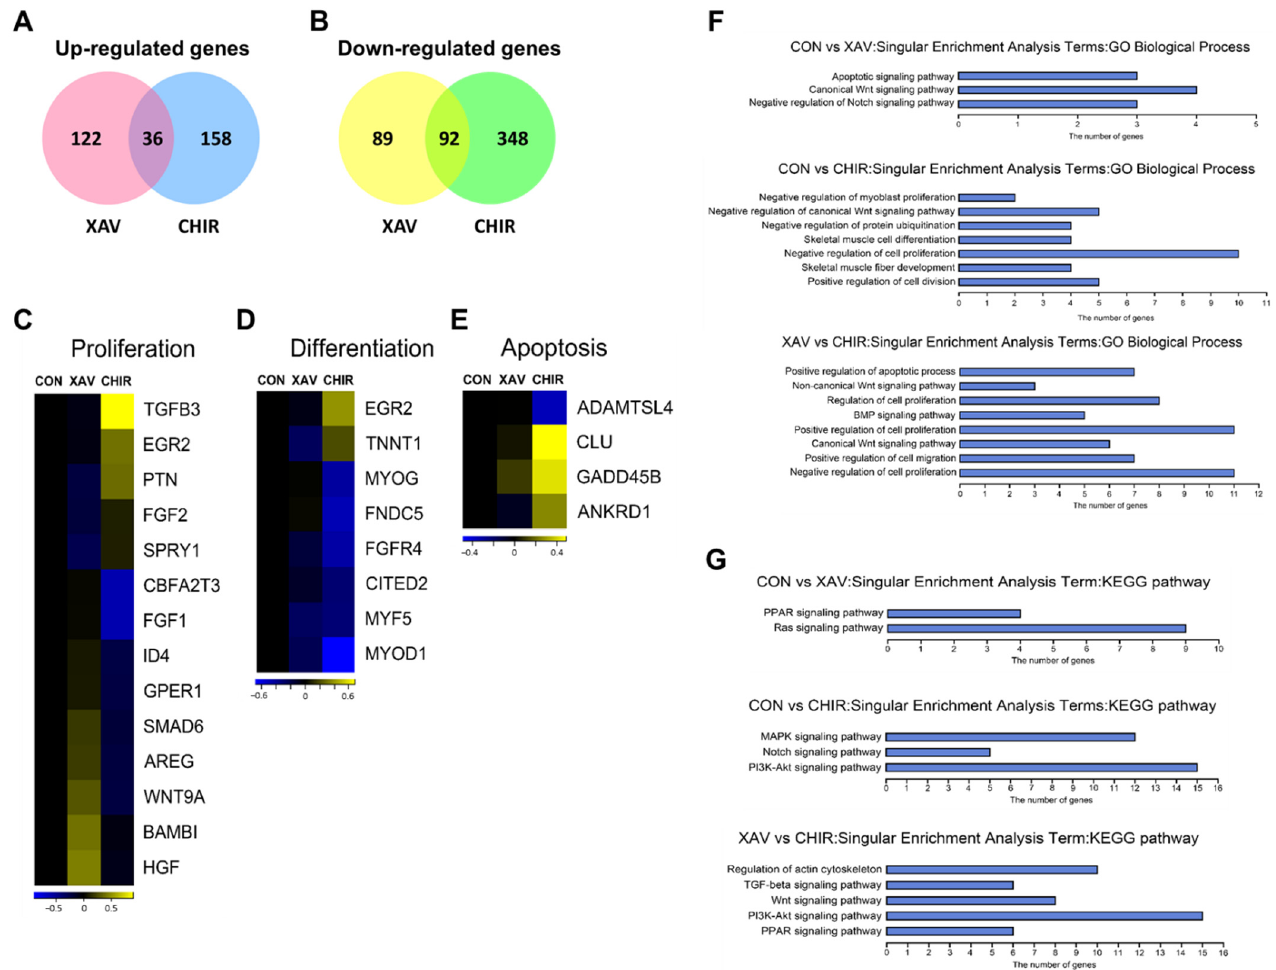
Figure 5. Differentially expressed genes (DEGs) in XAV939 and CHIR99021 treated PMSCs. ( A ) Up- regulated genes in XAV or CHIR groups. ( B ) Down-regulated genes in XAV or CHIR groups. ( C ) Heat map of muscle cell proliferation-related genes in PMSCs. ( D ) Heat map of muscle cell differentiation- related genes in PMSCs. ( E ) Heat map of apoptosis-related genes in PMSCs. ( F ) Gene ontology (GO) term and ( G ) KEGG pathway analysis of DEGs selected from PMSCs.